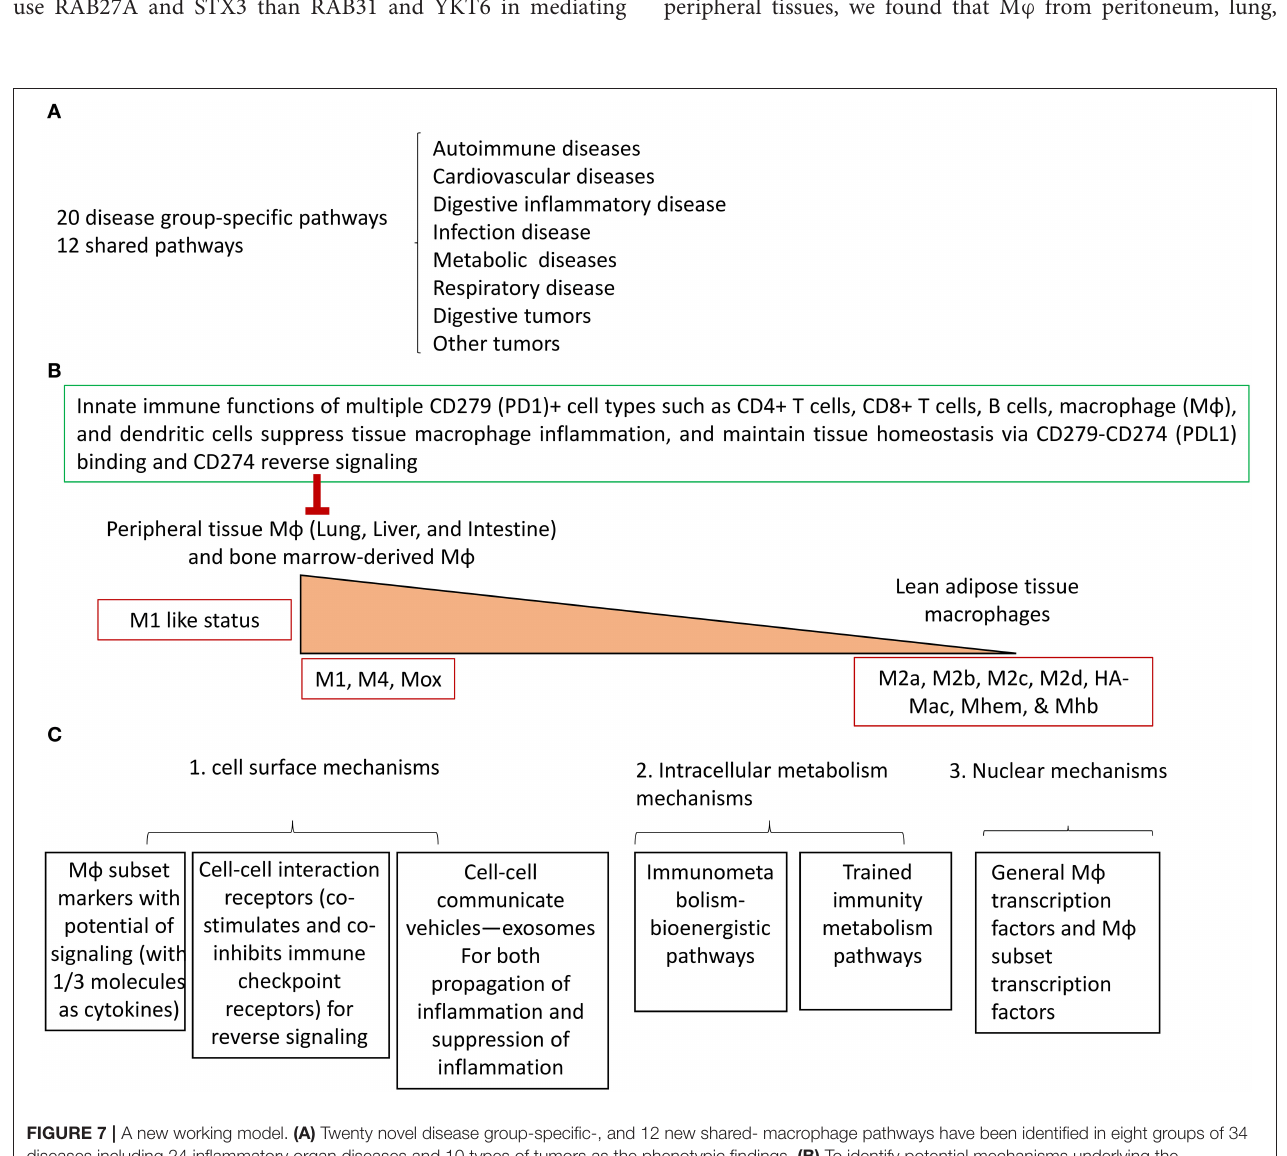
Frontiers in Immunology |